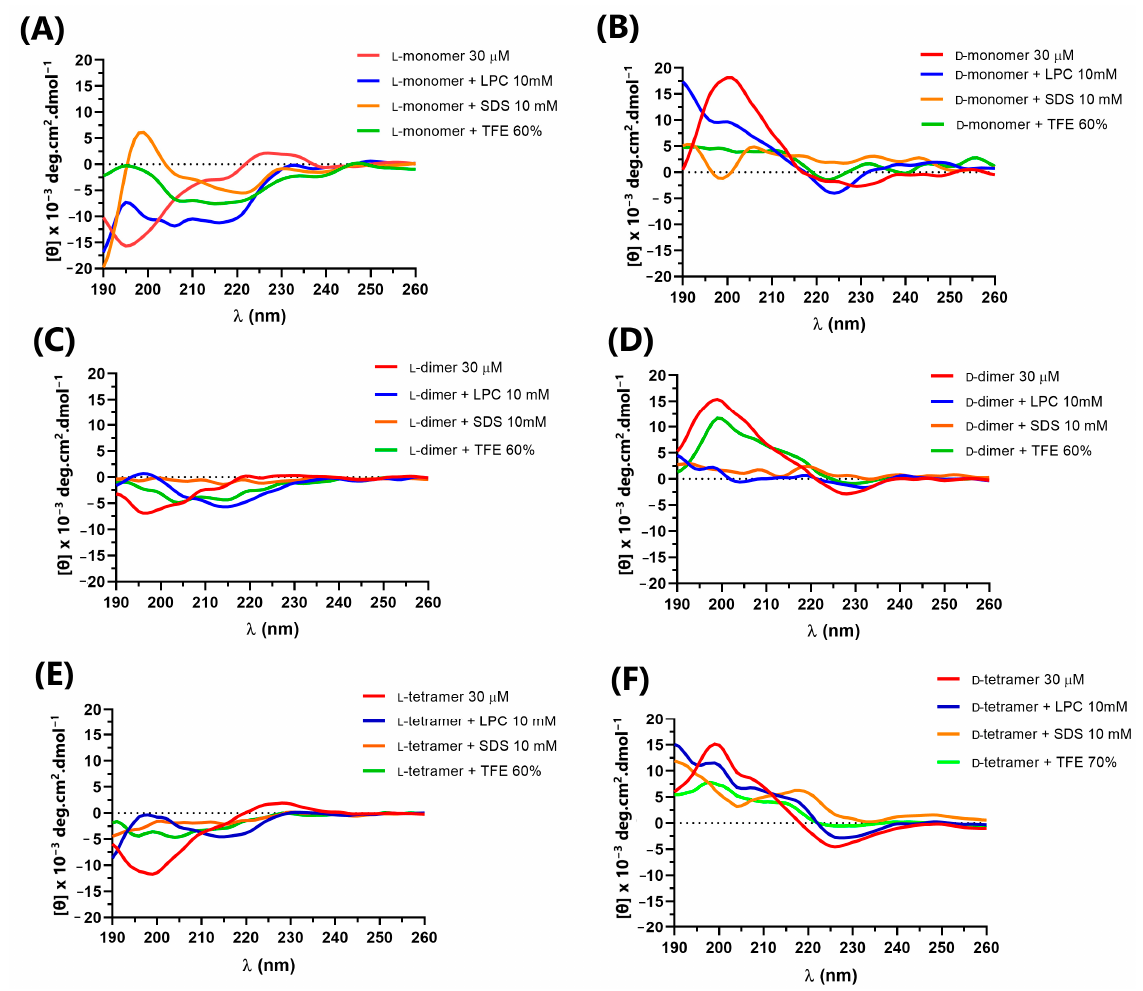
Figure 3. Circular dichroism of peptides: ( A ) L-monomer, ( B ) D-monomer, ( C ) L-dimer, ( D ) D-dimer, ( E ) L-tetramer, and ( F ) D-tetramer at 30 µ M in PBS, LPC, SDS and TFE. In an aqueous solution, the L-peptides did not present defined secondary structures.